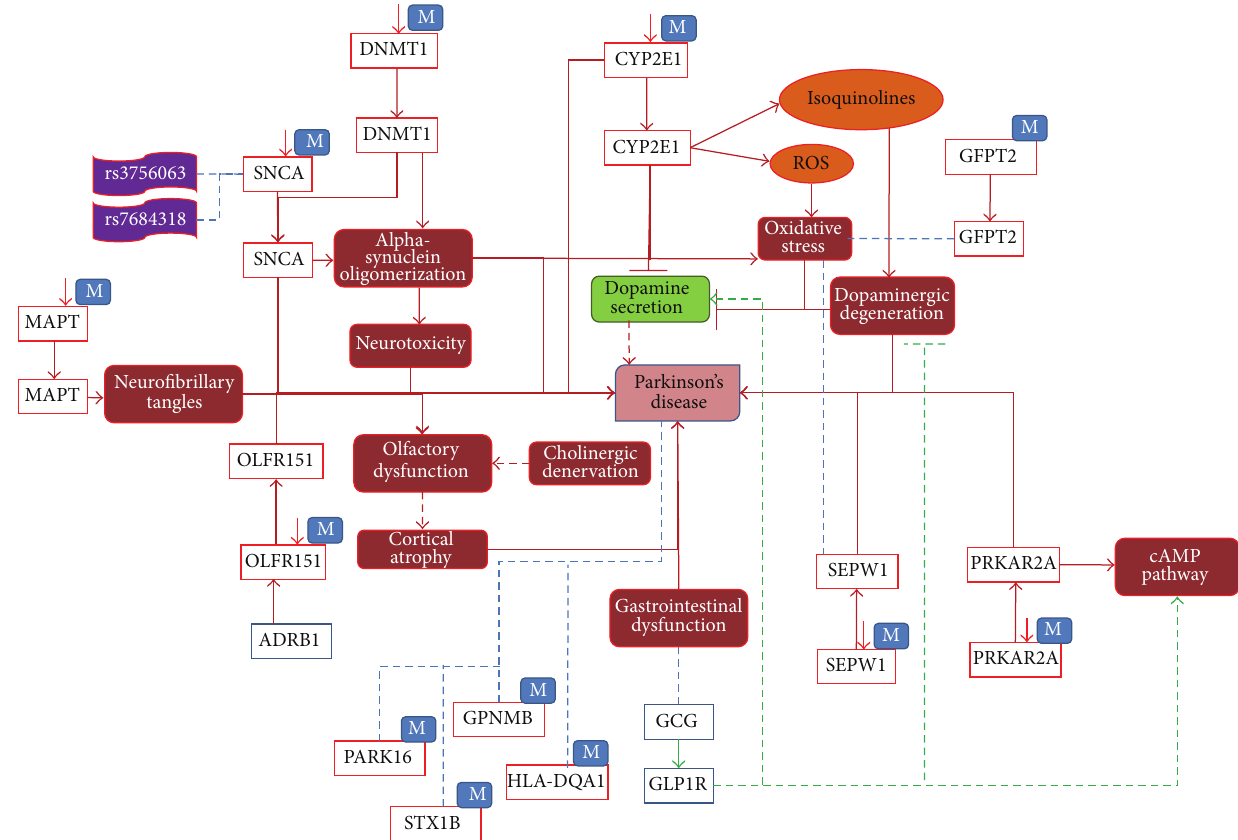
Figure 2: The role of epigenetics modification; hypomethylation around certain genes in PD. In this figure, red lines indicate the disease state interactions and green lines show normal state. Blue lines show the association between entities with unknown direction. Dotted lines are the interpretation, which needs to be further analysed. “M” associated with a gene entity denotes a methylation process and down-arrows besides represent decreased